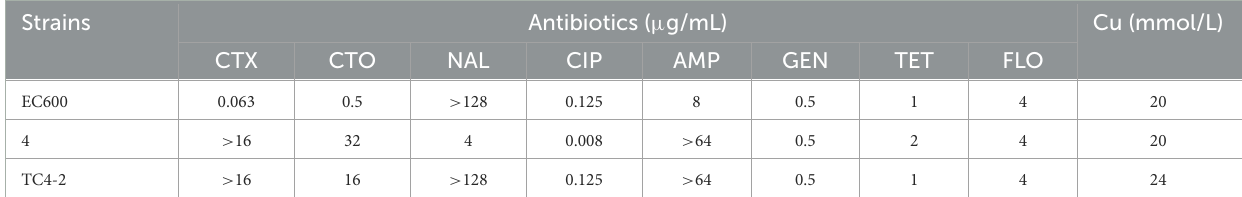
TABLE 3 Antibiotic and copper susceptibility of donor and recipient E. coli strains, and the corresponding transconjugant. Strains